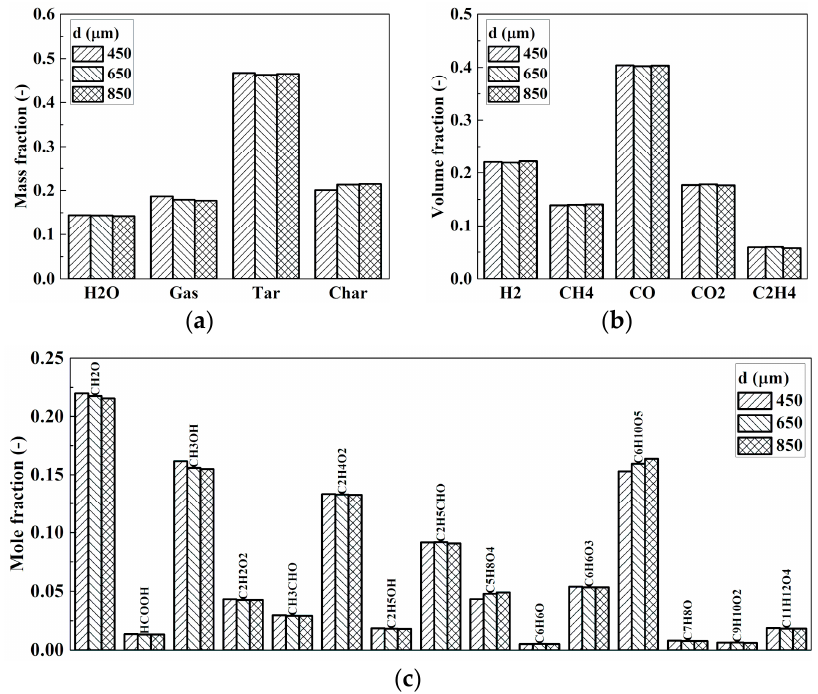
Figure 12. Pyrolysis products for different particle sizes. ( a ) H 2 O, light gas, tar, and char; ( b ) light gas species; and ( c ) tar species.